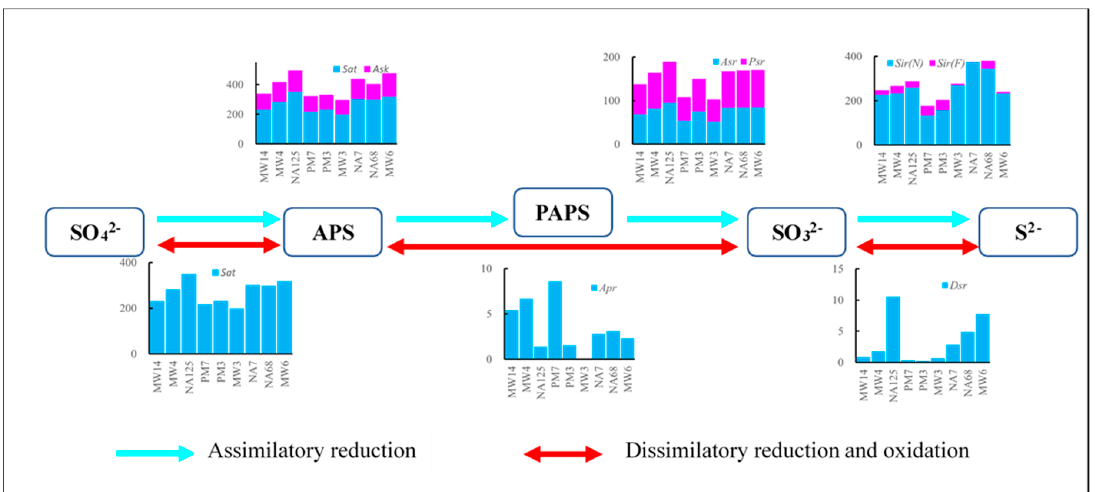
Figure 5. Gene abundance of nitrogen metabolism pathways in the aquifer. APS, adenylyl sulfate; PAPS, 3’-phosphoadenylyl sulfate.